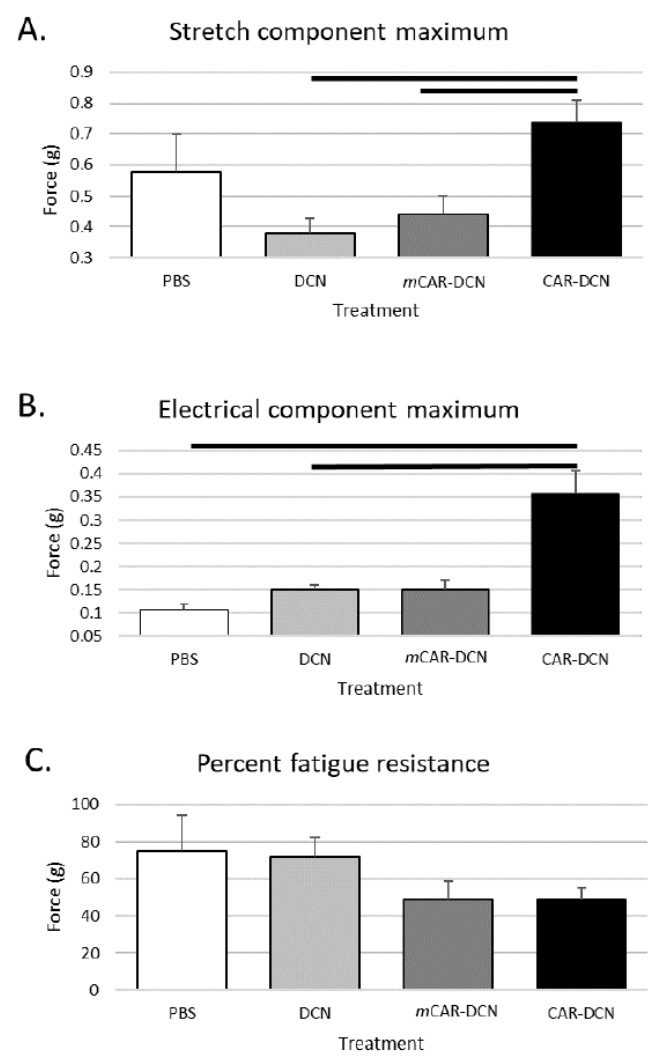
Figure 10. Gastrocnemius/soleus muscle tissues of mdxD2 mice treated with CAR-DCN for three weeks are able to produce more force than muscle tissues of the control mdxD2 mice. ( A ) The stretch component test indicated significant force improvement in the CAR-DCN muscles. ( B ) The increased force was also demonstrated when assessed by the electrical component of the test. ( C ) However, mdxD2 mice treated with CAR-DCN did not show improvement in percent fatigue resistance. The solid lines indicate statistical significance ( p < 0.05). n = 6, 11, 9, 10 animals, respectively.